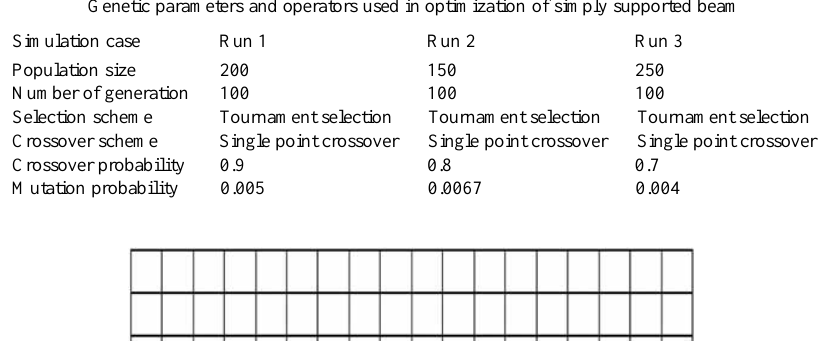
Table 2 Genetic parameters and operators used in optimization of simply supported beam